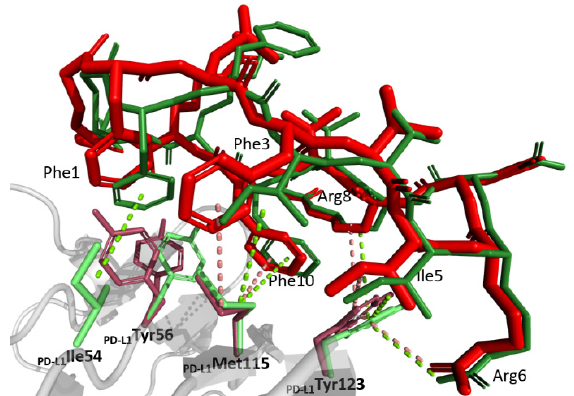
Figure 3. Comparison of the binding modes of p104 and p101 at the surface of PD-L1 receptor. Peptide 104 (red) and peptide 101 (green, single conformation; the second conformation is not shown for clarity) binding to PD-L1 (gray; residues relevant for interactions are shown in pink and light green, respectively, for p104- and p101-containing structures). Major interactions are depicted with dotted lines.